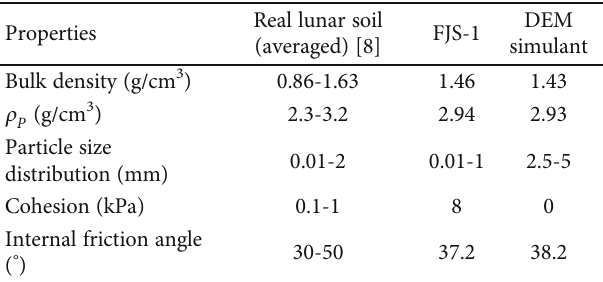
Table 3: Static mechanical property